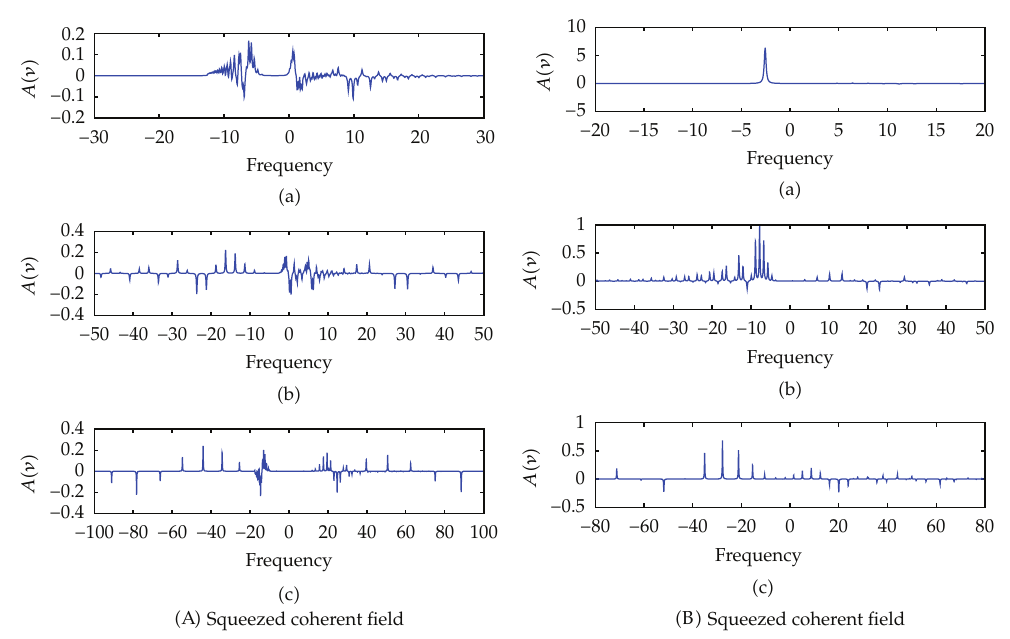
Figure 4: The same as Figure 2 (cid:5) B (cid:8) but with (cid:5) 1 (cid:8) χ (cid:9) 0 . 1 and (cid:5) 2 (cid:8) χ (cid:9) 0 . 8.